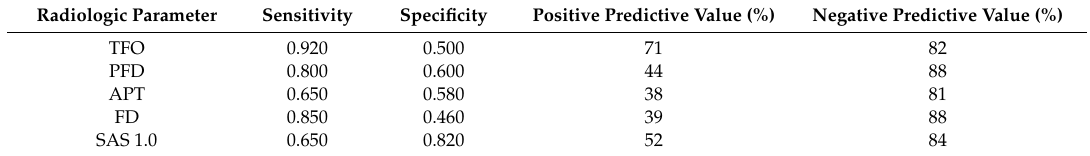
Table 4. The sensitivity, specificity, and positive and negative predictive values of ratio of